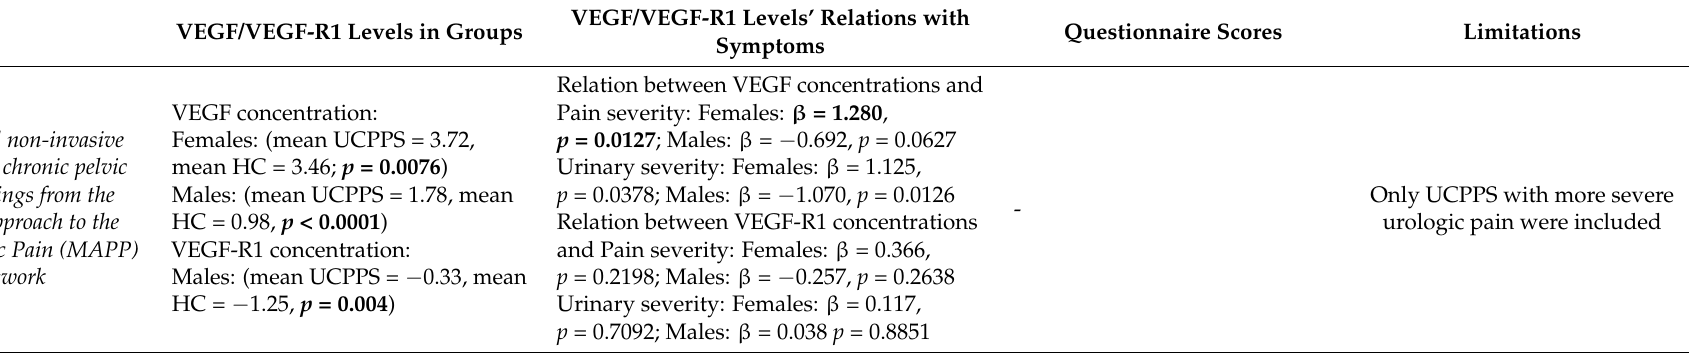
Table A5. Table with studies’ findings and